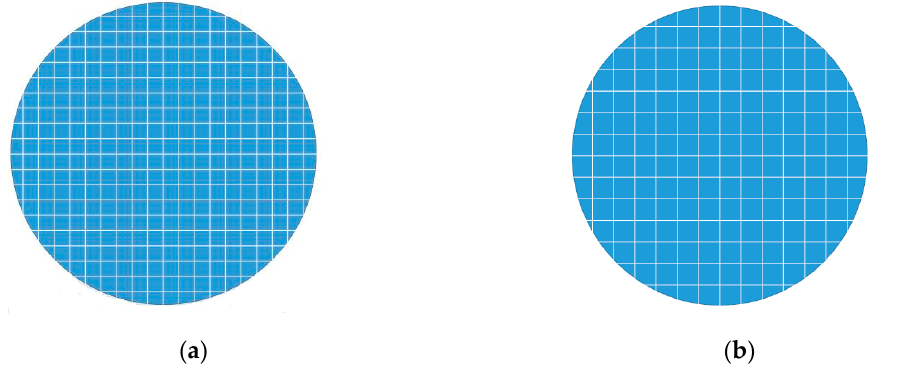
Figure 7. Discretization of the cross-section. ( a ) Cartesian grid with a mesh size of 7.0 mm (Section 4); ( b ) Cartesian grid with a mesh size of 2.5 mm (Section 5).